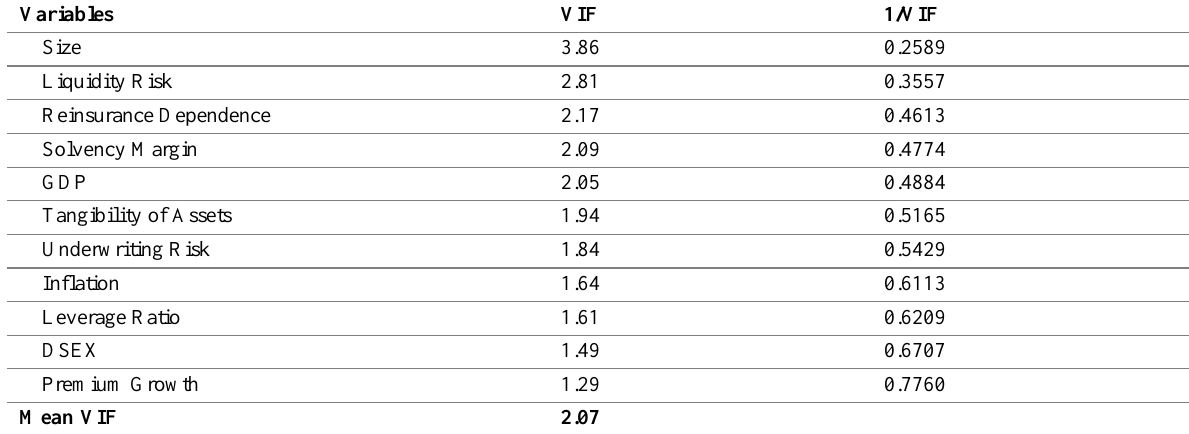
Table 12: Variance Inflation Factor